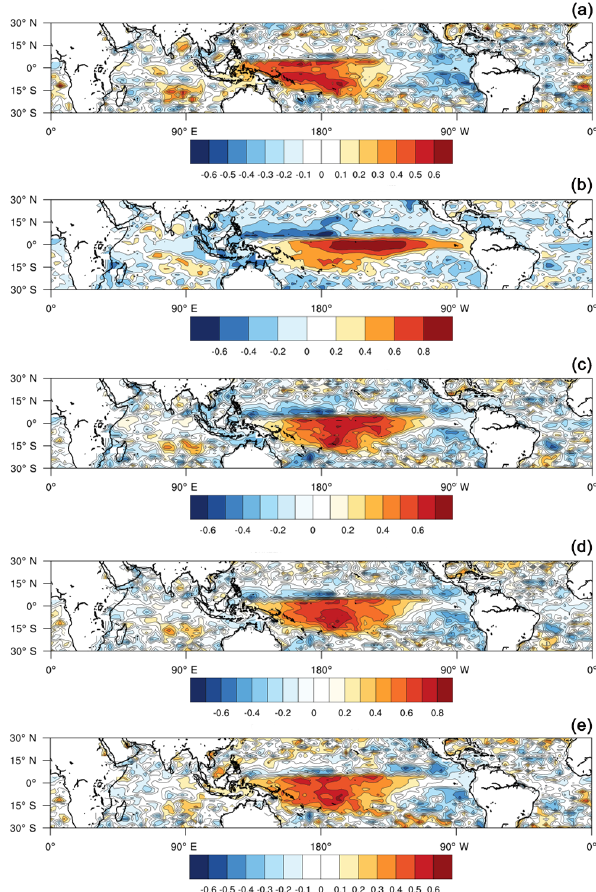
Figure 7. (a) The summer HC field reconstructed from the observa- tions, from (b–e) represent the correlations maps between the sum- mer HC field and the coefficients temporary of T-model, NP, SAIA and RB region, respectively.